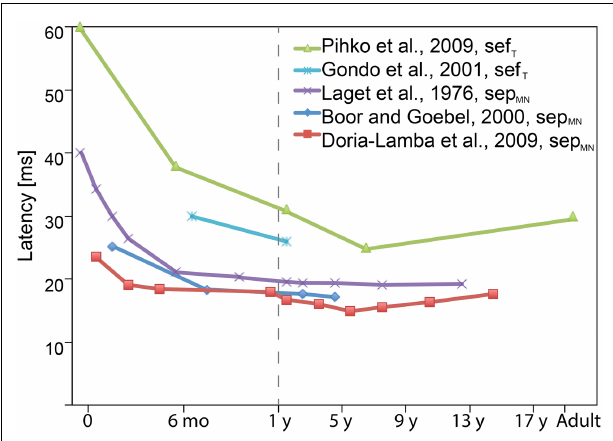
FIGURE 3 | Schematic diagram showing the latency evolution of the earliest cortical sep MN 30 and sef T 30 components with age as reported in various studies .The general rule is that the sep MN 30 and sef T 30 latency decreases until the age of approximately 3–5years, and slightly increases thereafter.The absolute latencies vary between studies due to differences in, e.g., stimulation methods and filter settings. Many of the studies also grouped subjects of different ages together in which case the figure displays the midpoint of the reported age range (when the average age was not reported). (Note the different age scales before and after 1